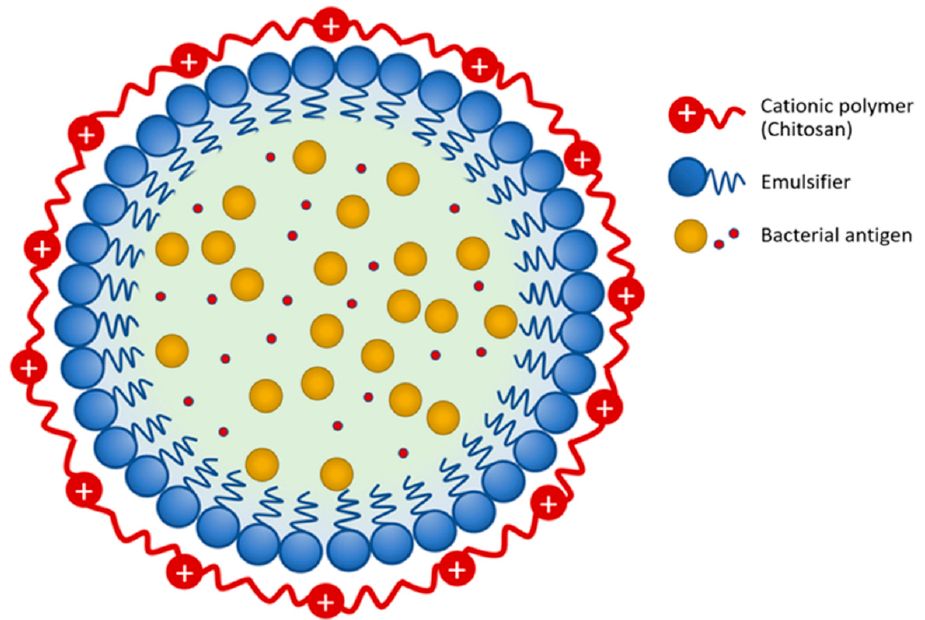
Figure 1. Schematic diagram of the in chitosan complex nanoemulsion vaccine.